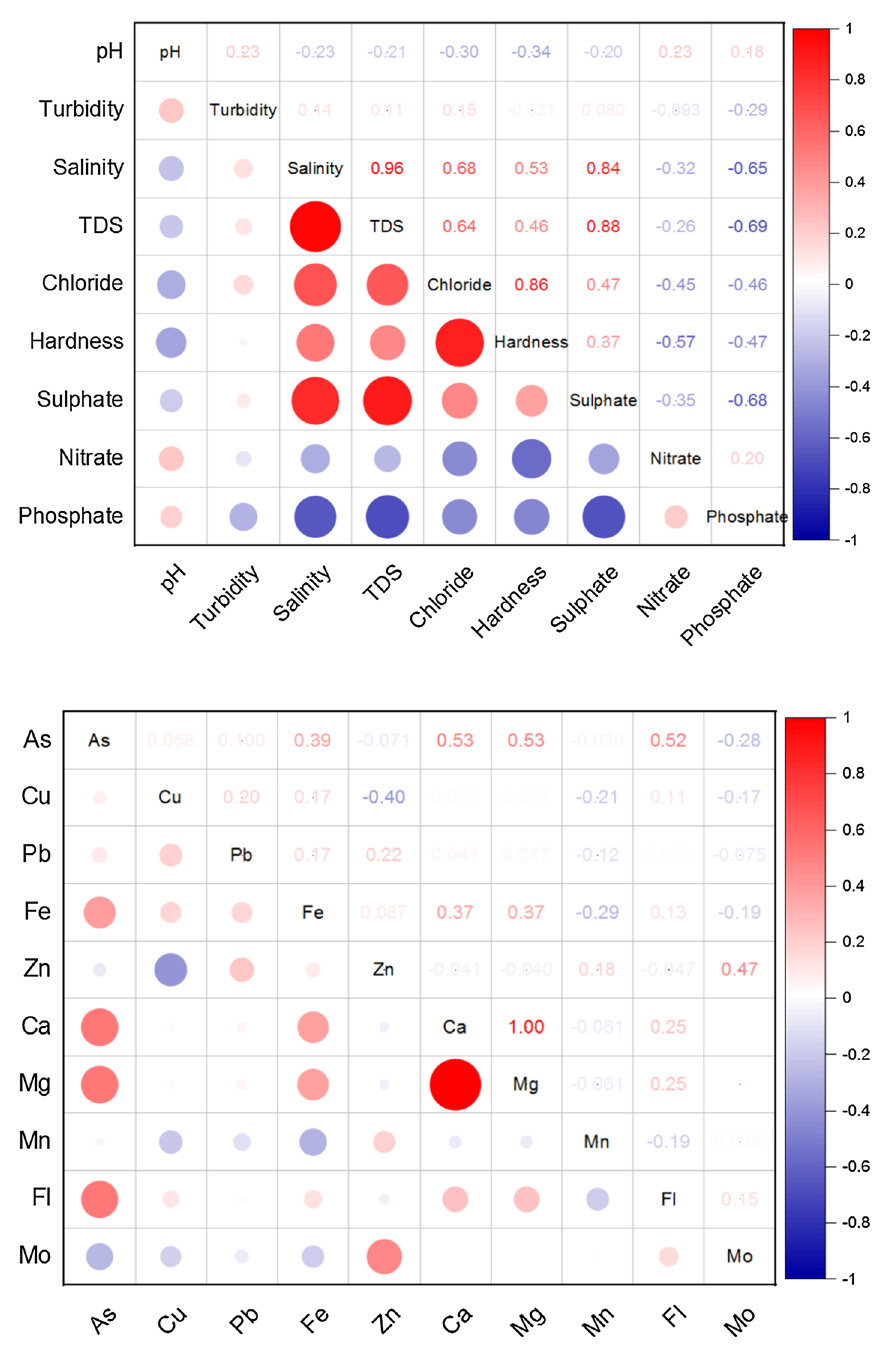
Fig. 5 Correlation among physico-chemical parameters in Chu Tran Valley water samples